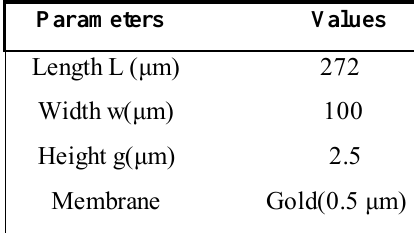
Table-V: Physical parameters of the designed switch Parameters